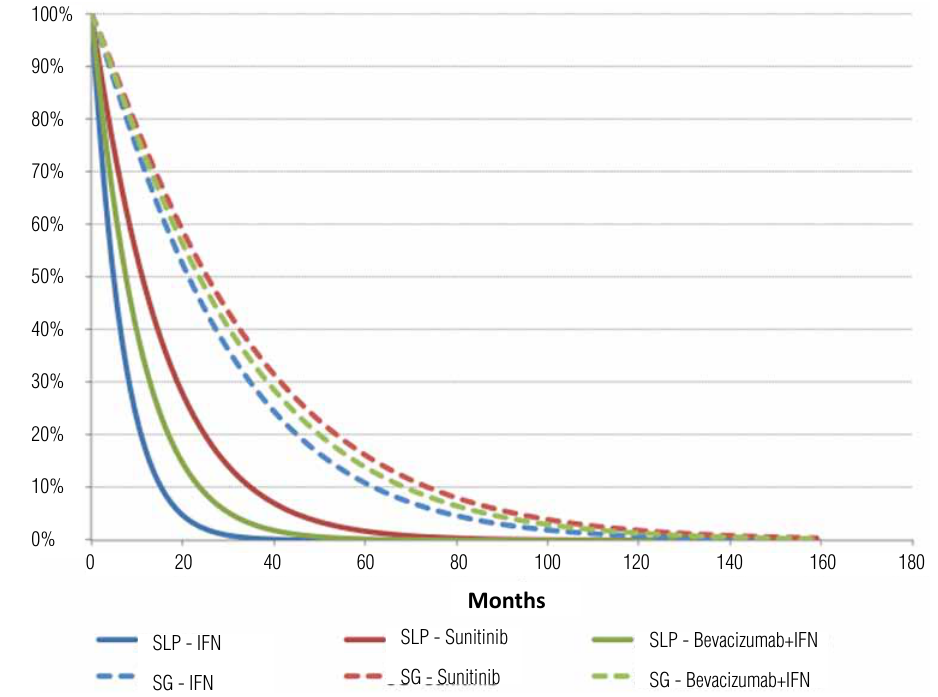
Figure 5 - Free survival progression and total survival curves for first line treatment.